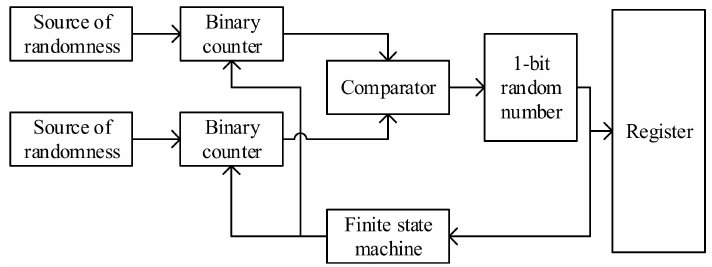
Figure 2. Block diagram of TRNG